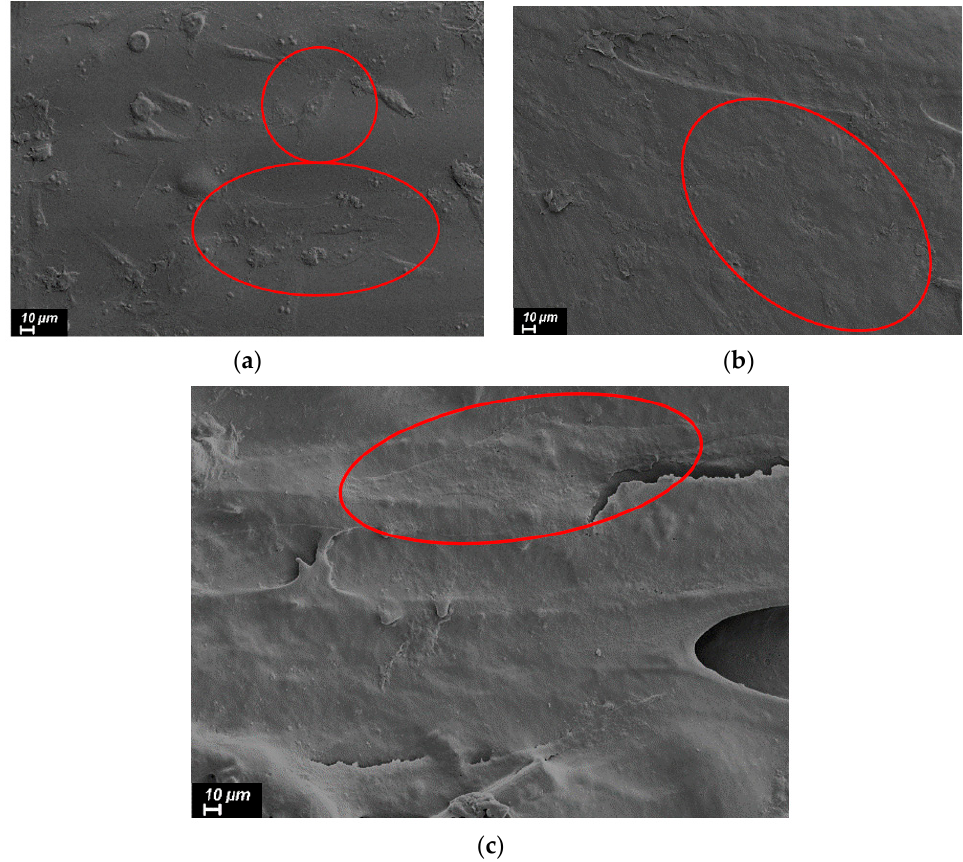
Figure 10. SEM images of cells 1 day after plating on the samples surface prepared by the FFF method from ( a ) pure R-BAPB, ( b ) R-BAPB + 1% VGCF, and ( c ) R-BAPB + 20% CF.